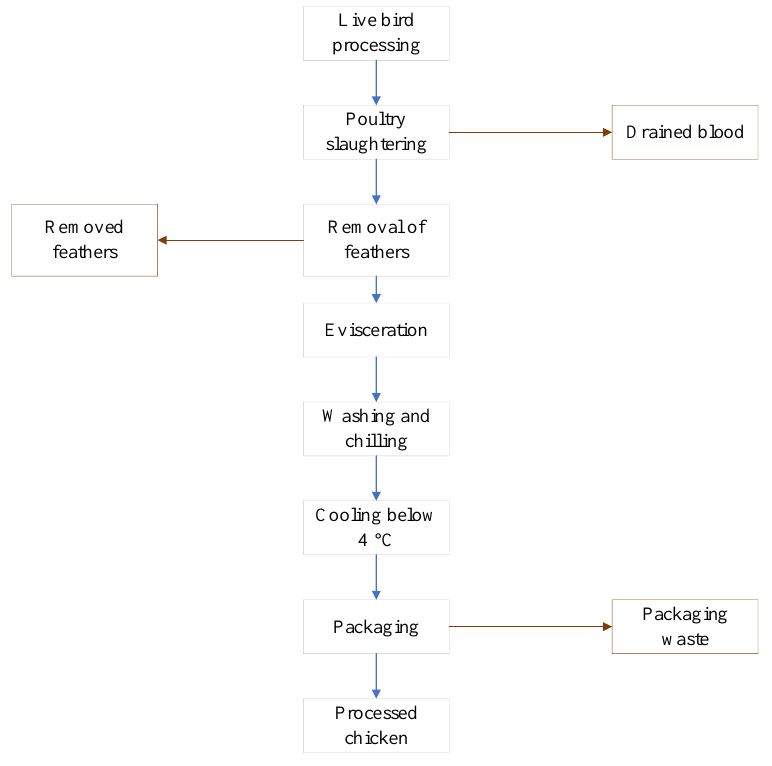
Figure 1. Poultry production flowchart.